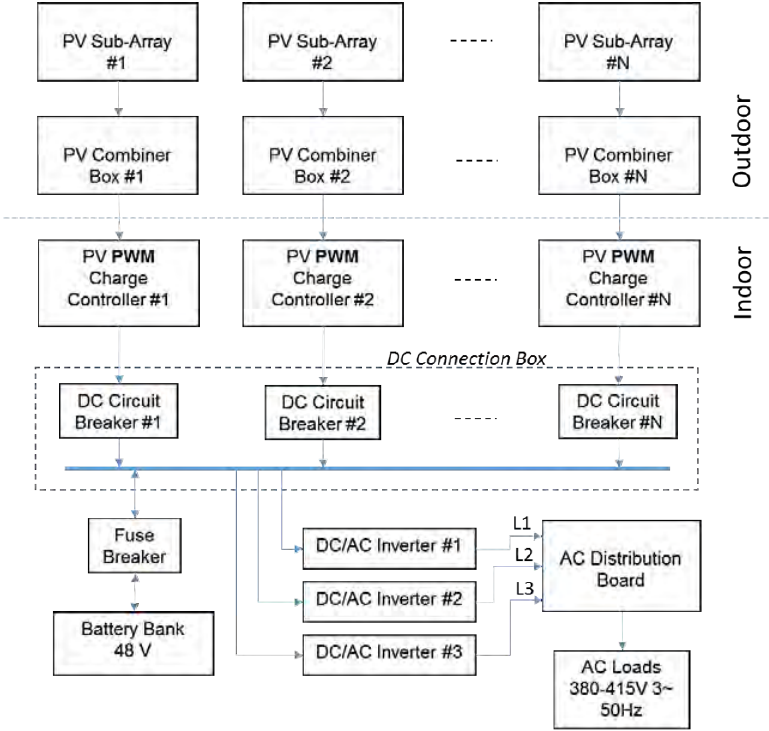
Figure 1. Design Block Diagram of the PV